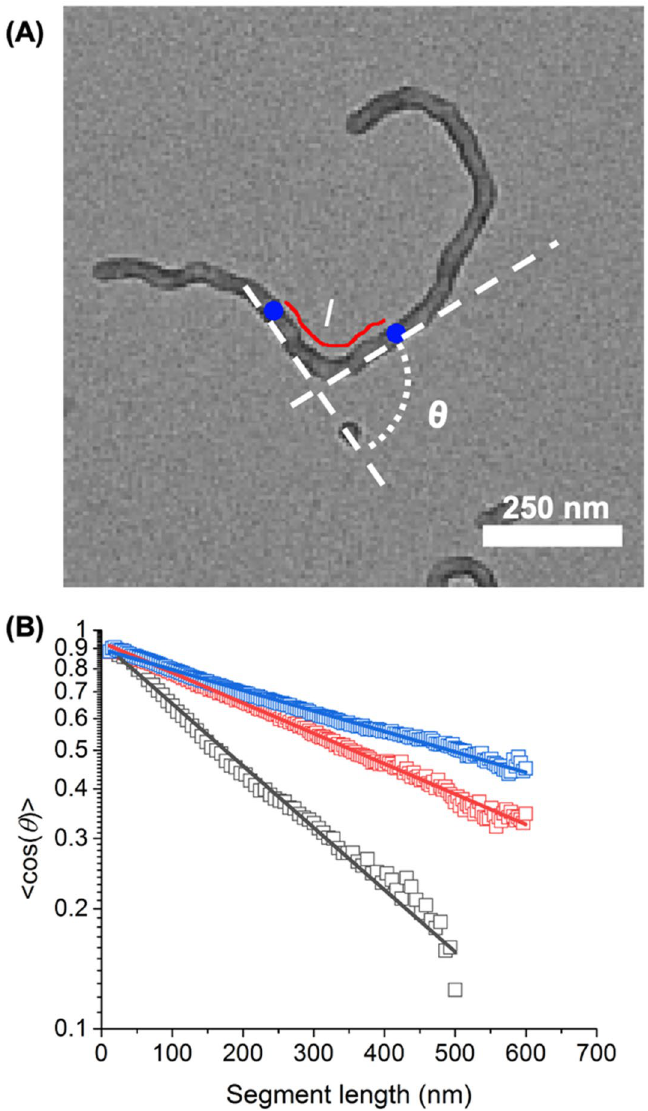
Figure 3. Persistence length of the micelles and crosslinked particles. ( A ) Parameter for the determination of the persistence length. ( B ) Decay of the tangent-tangent correlation for LWM NCC (Black), LWM LCC (Red), LWM HCC (Blue). The lines represent fits to Eq. 1. The data in B represent the average of the decay curves for 326 NCC, 133 LCC, and 258 HCC worm micelles,